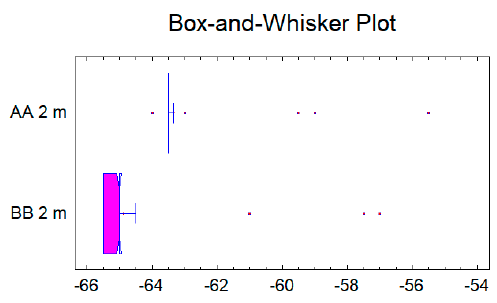
Figure 5. Box-and-whisker plot for reading distance 2 m.